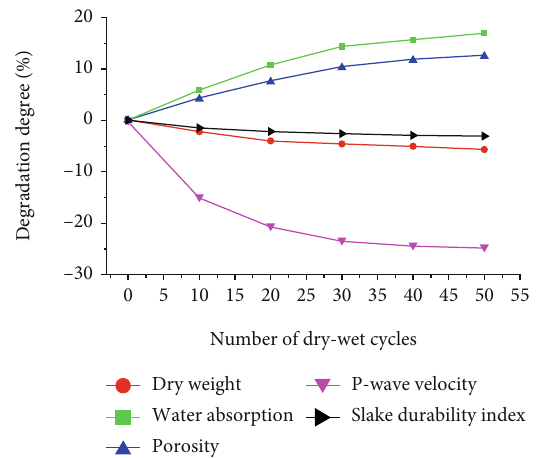
Figure 5: Degradation degree of physical properties of sandstone after dry-wet cycles [33].